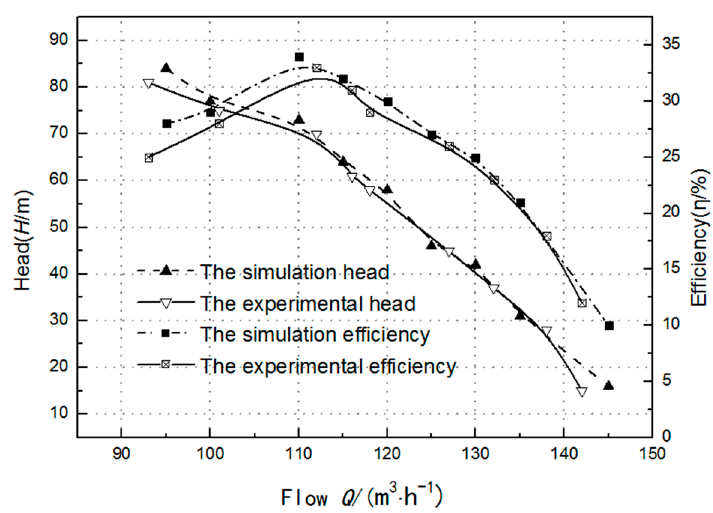
Figure 7. Comparison of experimental and numerical results.